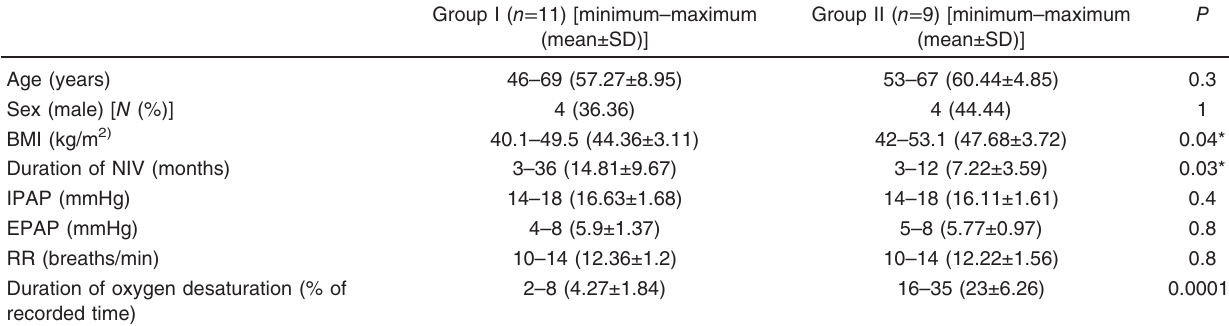
Table 3 Comparison between both groups as regards sociodemographic data, ventilation parameters, and overnight pulse oximetry results